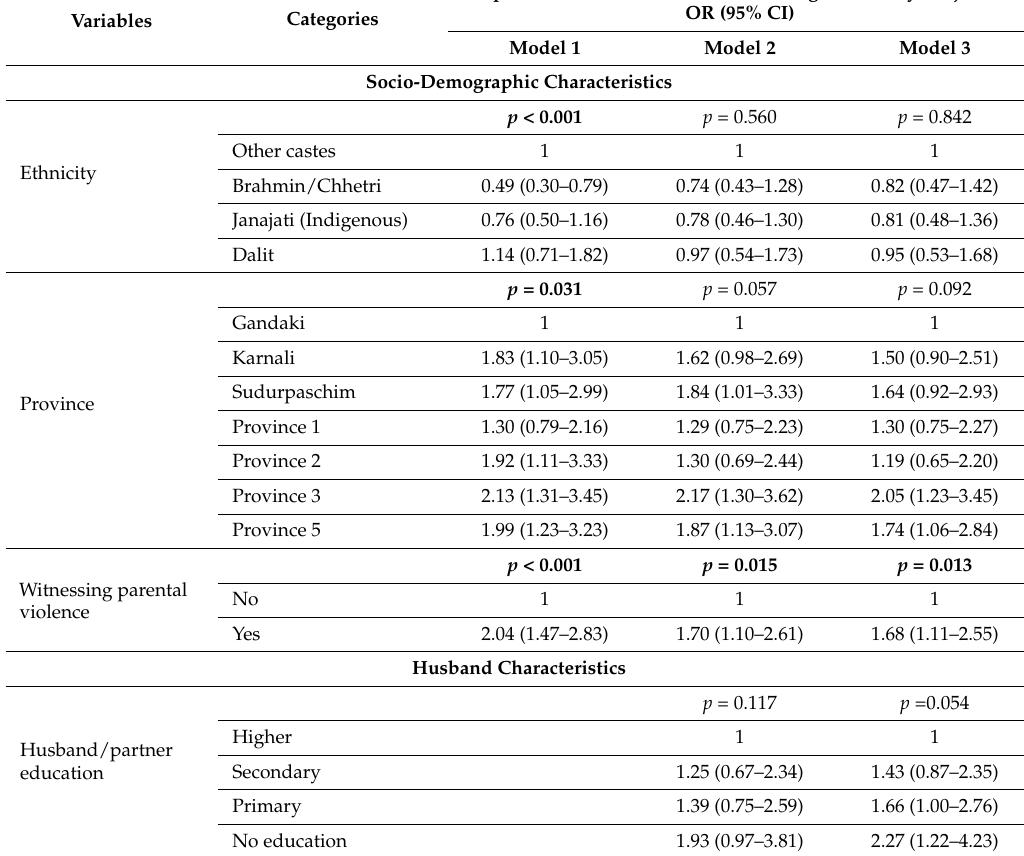
Table 7. Analysis of factors associated with experiencing IPV in the year preceding the survey among women in Nepal, 2016